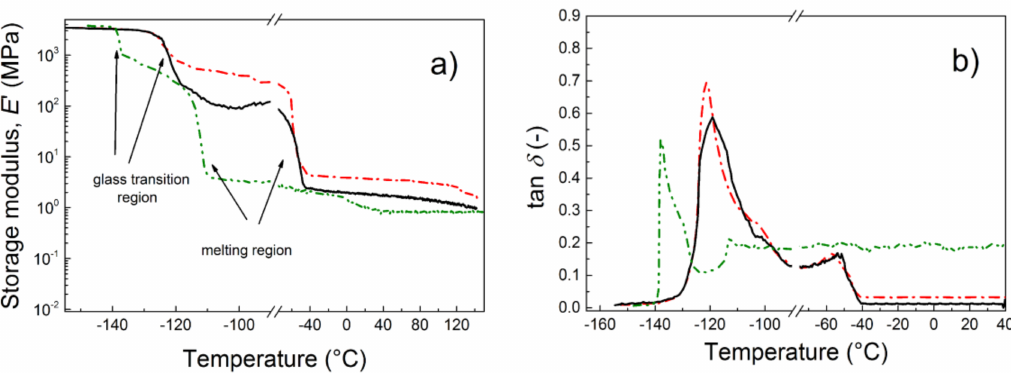
Figure 7. Dependence of the storage modulus ( a ) and tan δ ( b ) for a broad temperature range for a neat PDMS (black solid line), and for PDMS composites containing 0.1 vol % of either the neat GO (red dash–dot line) or the GO–PHEMATMS (green dash–dot–dot line).